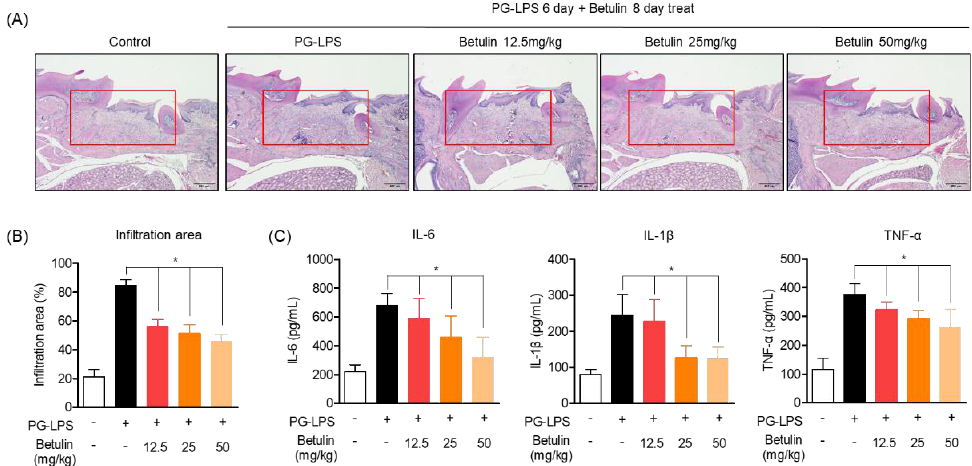
Figure 7. Inhibitory effect of betulin on periodontal tissue infiltration in PG-LPS-induced periodontitis in vivo model. Periodontal tissue infiltration due to periodontitis was analyzed by hematoxylin and eosin (H&E) ( A ) staining and is described in materials and methods Section 2.11. The quantification of infiltration was expressed as a percentage (%) of the infiltrating area from the total area of the marking (red area) ( B ). Measurement of pro-inflammatory cytokines using ELISA kit from serum of rats induced with periodontitis by PG-LPS ( C ). * p < 0.05 was considered significant differences between only PG-LPS treated groups. Each group ( n = 3).